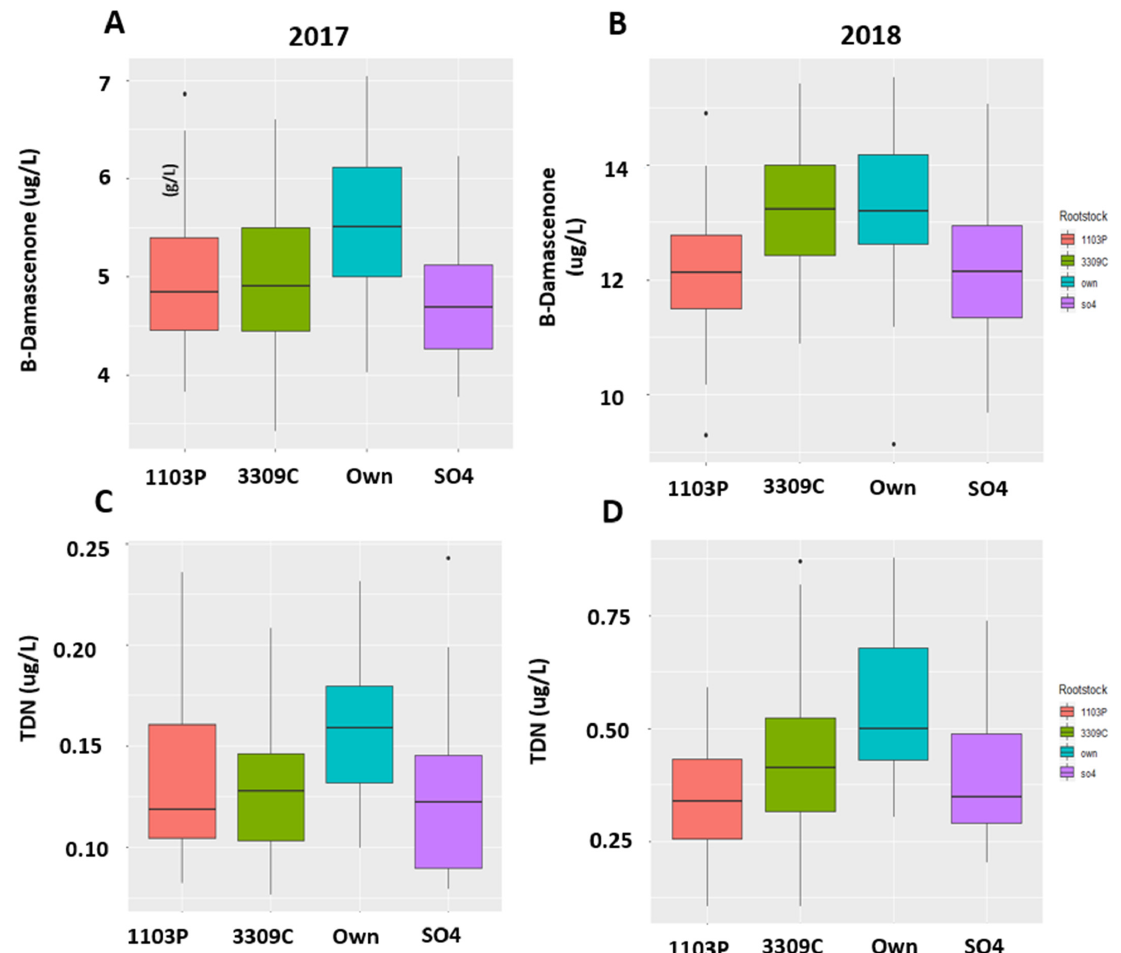
Figure 7. ( A ) Boxplots of β -Damascenone concentration differences in rootstocks and own-rooted Chambourcin in 2017 and ( B ) in 2018. ( C ) Boxplots of 1,1,6-trimethyl-1,2-dihydronapthalene (TDN) concentration differences in rootstocks and own-rooted Chambourcin in 2017 ( D ) in 2018. Both β -Damascenone TDN concentrations were found in higher in own-rooted Chambourcin in wines in both 2017 and 2018. Concentrations were measured in ppb (µg/L). Table 1. Mean concentrations of wine volatiles in 2017 and 2018 between rootstocks and irrigation . 2017 Compounds